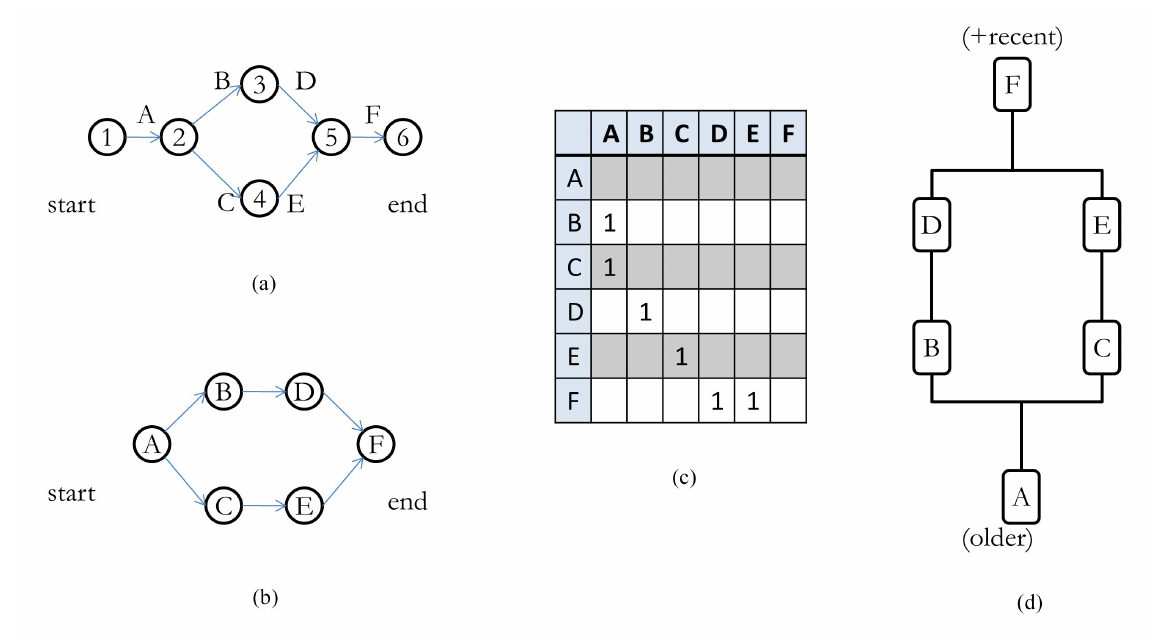
Figure 1. Relative temporal representations: ( a ) PERT diagram; ( b ) MPM diagram; ( c ) Harris matrix; ( d ) Harris